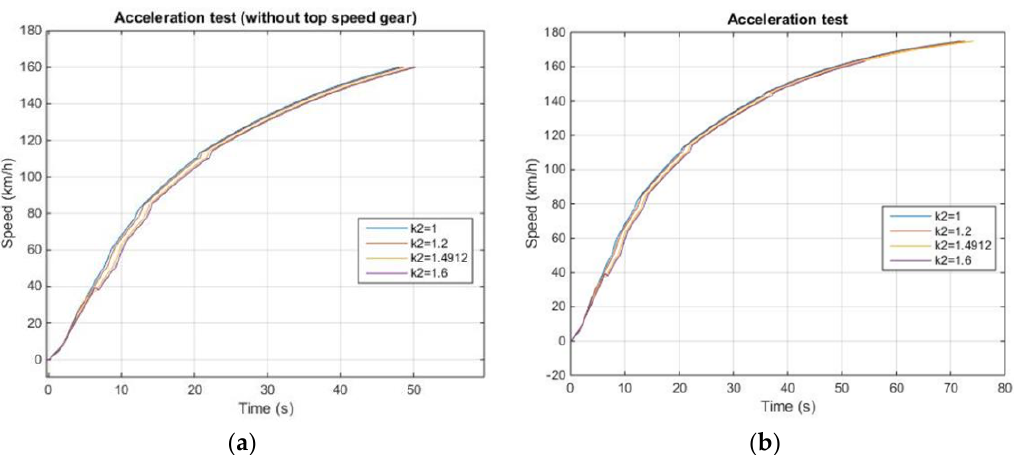
( d ) Figure 16. ( a ) Motor operation points (with 𝑘 2 = 1 ). ( b ) Motor operation points (with 𝑘 2 = 1 .2). ( c ) Motor operation points (with 𝑘 2 = 1 .4912). ( d ) Motor operation points (with 𝑘 2 = 1 .6). 3.2. Top Speed and Acceleration Test Figure 17 shows that, in both 0 – 60 km/h and 0 – 100 km/h acceleration tests, smaller 𝑘 2 values provide improved acceleration ability. Figure 17a presents the acceleration test results from the start to the top speed without the top speed gear. Table 8 reveals that differences in 𝑘 2 values did not influence the top speed, because the fourth gear is designed for the engine-only mode. Although the propulsion system can provide excess torque in the hybrid mode, the maximum vehicle speed is limited by the TW speed, which the gear ratio of the fourth gear constrained. Figure 17b presents the acceleration test results from the start to the top speed with the top speed gear. The top speed at 𝑘 2 = 1, 𝑘 2 = 1.2, and 𝑘 2 = 1.4912 are almost the same, but they are slightly lower than the ideal maximum speed, which is the speed of engine at maximum power condition in hybrid mode. The top speed at 𝑘 2 = 1.6 is lower than that at other 𝑘 2 values, because the rotation speed before the gearbox is limited